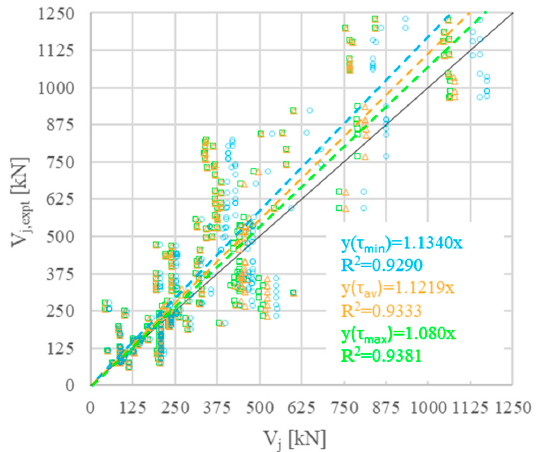
Figure 8. Experimental and numerical comparison for T-shaped RC joints under negative column shear: minimum bond stress (blue), average bond stress (orange), and maximum bond stress (green).